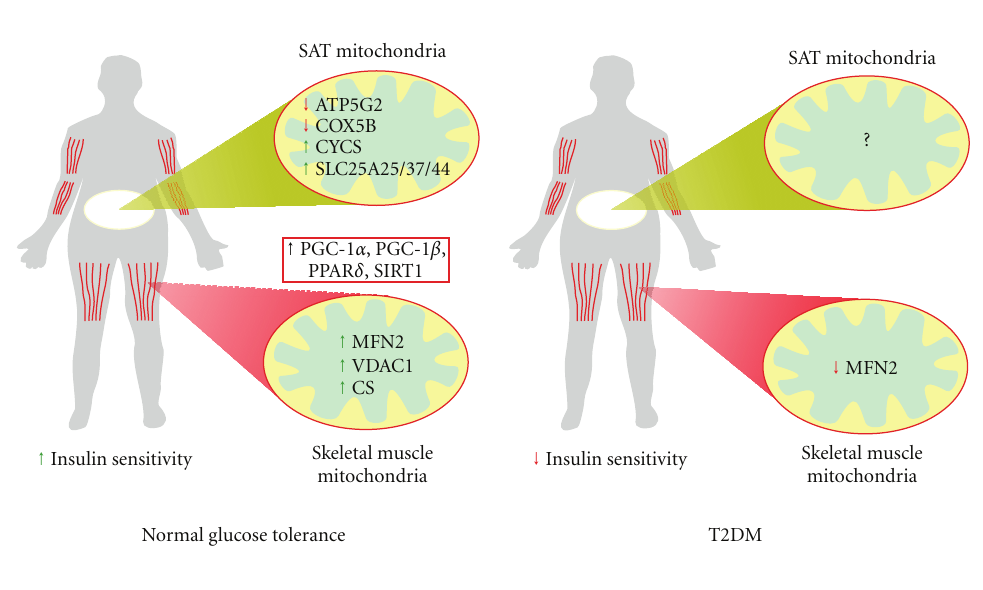
Figure 2: Summary of altered mitochondrial and mitochondrial biogenesis (boxed) gene expression in skeletal muscle of morbidly obese patients with normal glucose tolerance or type 2 diabetes mellitus (T2DM) [86] and in subcutaneous adipose tissue (SAT) one year after BPD/DS surgery [49]. Arrows indicate the direction of the altered gene expression after bariatric